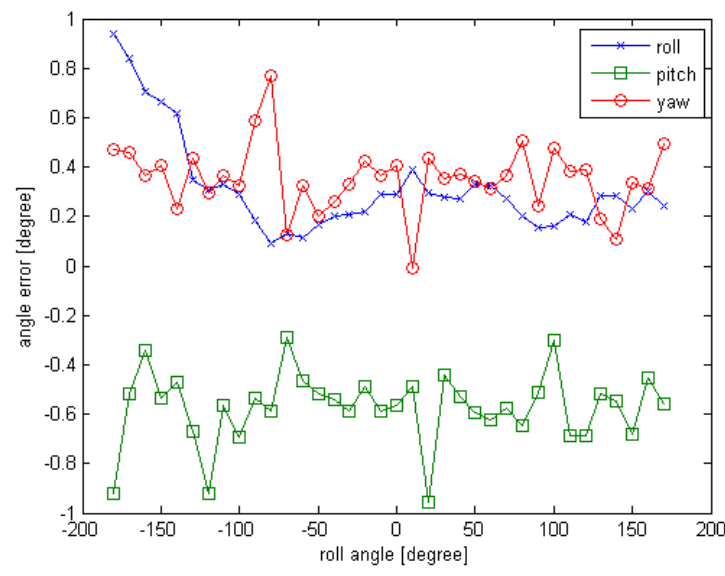
Figure 6. The rotation error curve of Experiment 1 for initial pose.